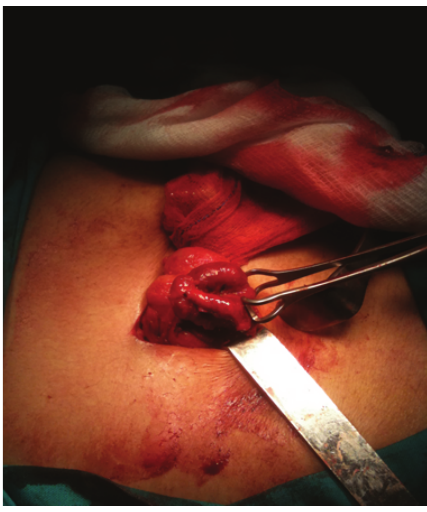
Figure 1: A solitary cecal